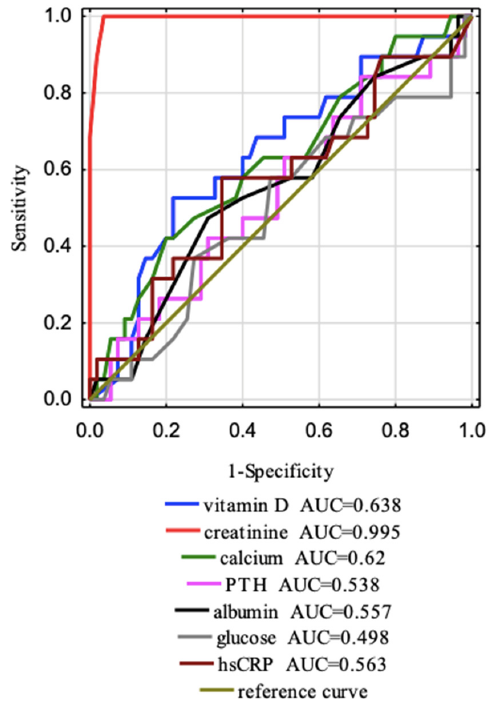
Figure 6. Seven ROC curves and AUC values of the clinical parameters were designed to distinguish factors that affect the eGFR stages (G1 and G2).